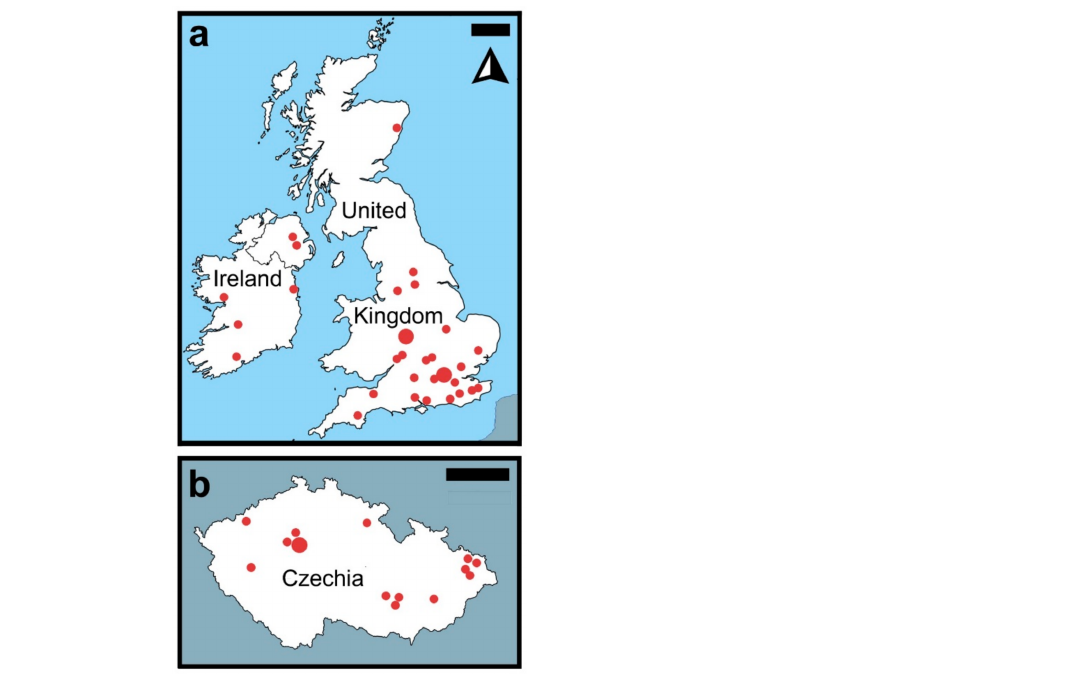
Figure 3. The distribution of Ctenolepisma longicaudatum in the United Kingdom, and Ireland ( a ) and in Czechia ( b ). Sources: iNaturalist, Observation.org, What’s Eating Your Collection, the Killgerm database and collected citizen reports.